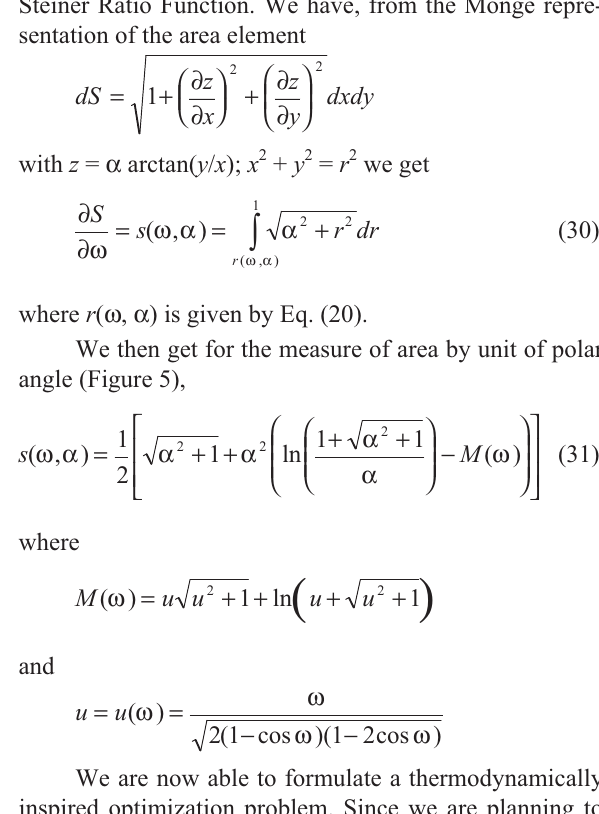
Figure 5 - The surface s( ω , α ). The area measure